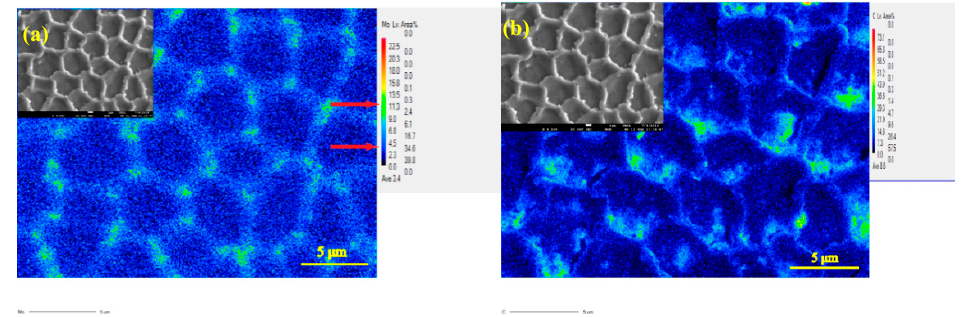
Figure 7. The electron probe micro-analyzer images of ( a ) Mo and ( b ) C.